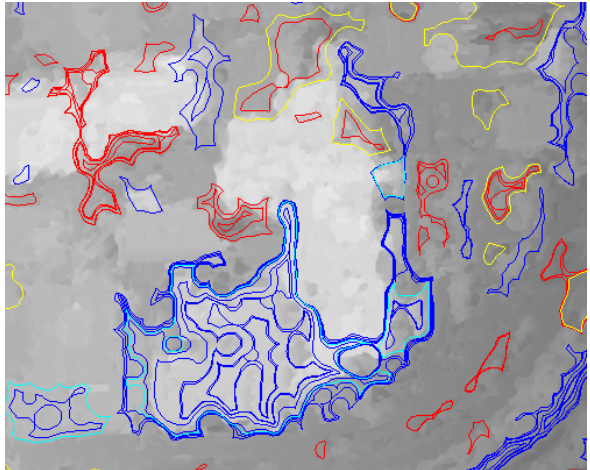
(a) On our running example: the two components circled in Figure 1 are well separated